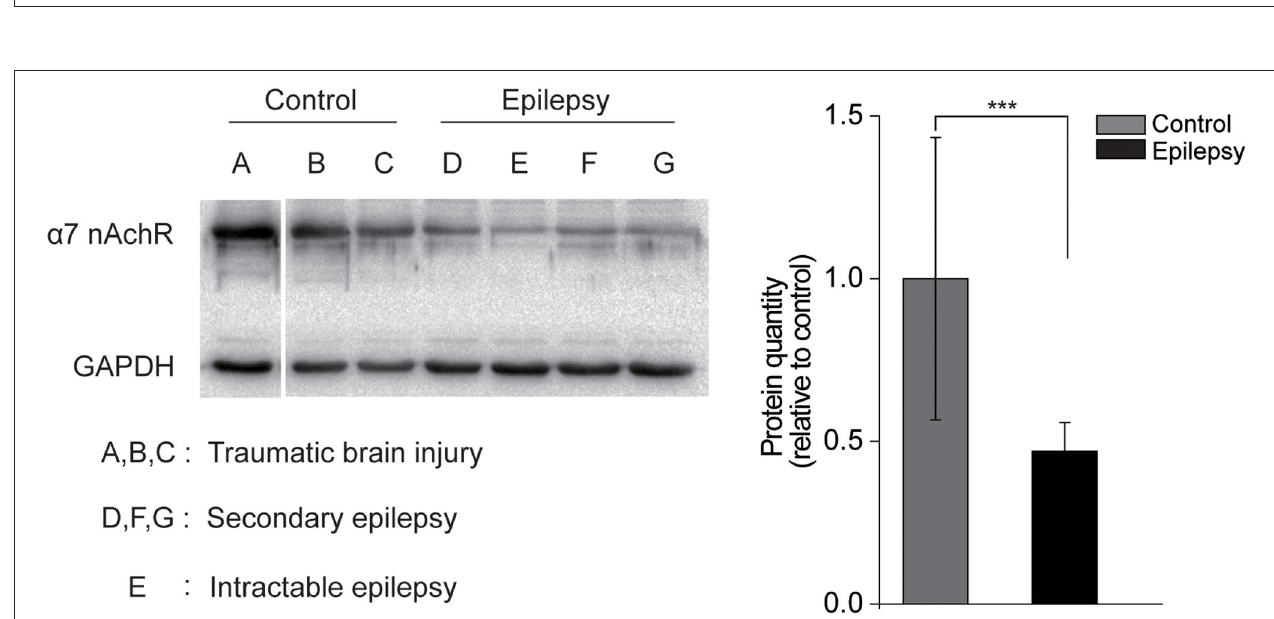
FIGURE 4 | Decreased α 7 nAChRs expression in human epileptogenic tissue. (A) Immunoblotting with α 7 nAChRs in the membrane fraction of cortex from control individuals or individuals with epilepsy. Each lane was loaded with 40 µ g of protein with GAPDH as the loading control. (B) Quantification of α 7 nAChRs proteins in control and epilepsy groups. n = 3. Protein levels of epilepsy tissue were normalized to the corresponding ones of non-epilepsy tissue. *** P < 0.001; Error bars are means ± s.e.m.